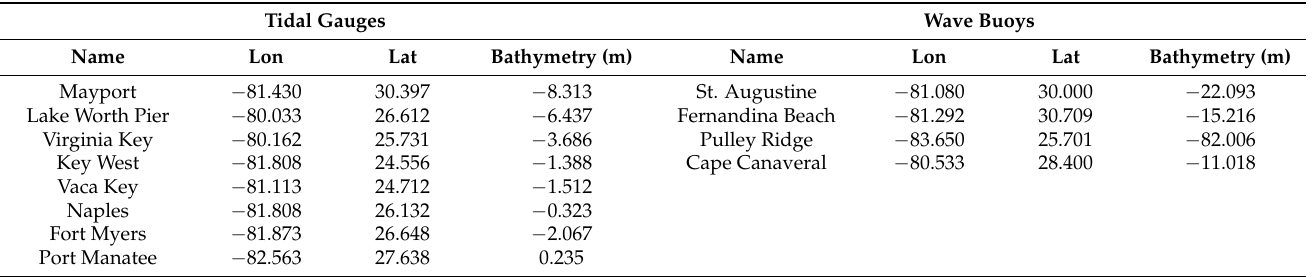
Table 1. Geo-locations and bathymetry of tidal gauges and wave buoys used in the